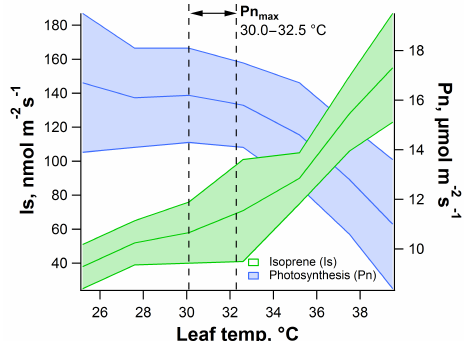
Figure 3. Average net photosynthesis (Pn) and isoprene emissions (Is) from V. guianensis leaves as a function of leaf temperature (average ± 1 standard deviation, n = 5 leaves) under constant PAR of 1000µmolm − 2 s − 1 and 400ppm reference [CO 2 ]. Note the de- cline in Pn and the increase in Is with leaf temperature above 30.0– 32.5 ◦ C, where the majority of leaves showed an optimum in Pn. Pn was determined with a portable photosynthesis system (LI-6400XT, LI-COR Inc., USA) and Is was determined using thermal desorption